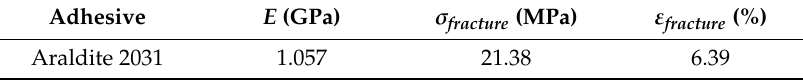
Table 4. Mechanical properties of the adhesive Araldite 2031, as provided by the manufacturer (Huntsman Advanced Materials GmbH, Basel, Switzerland).